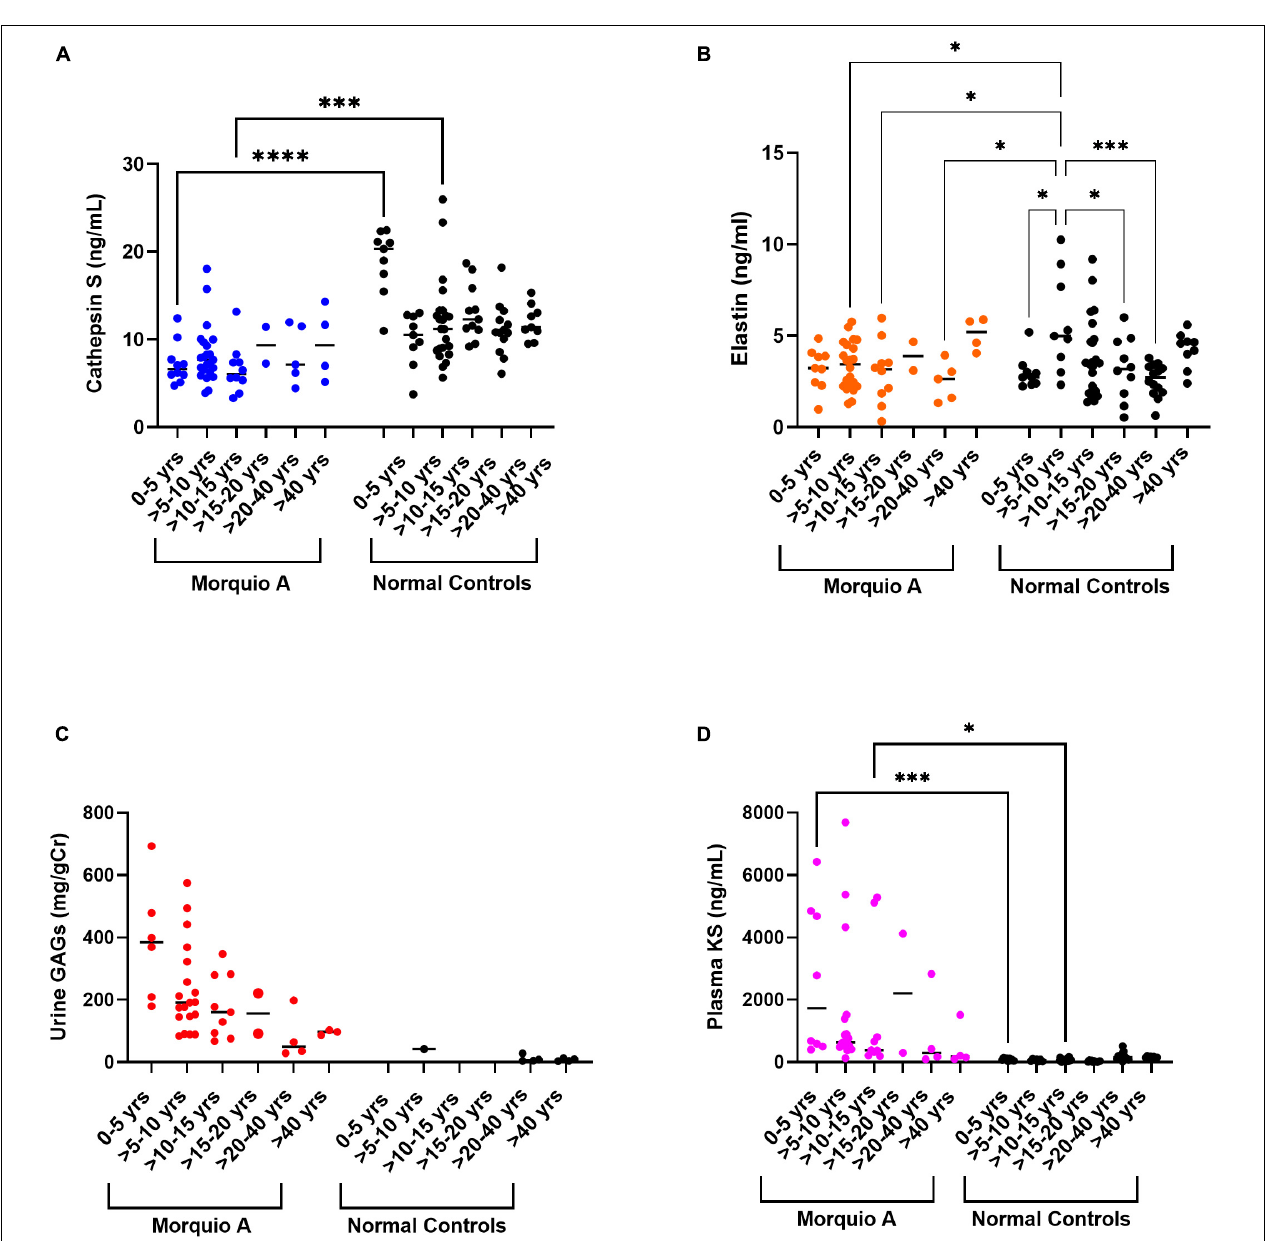
FIGURE 5 | Biomarkers comparisons between Morquio A and normal controls. Comparison of (A) Cathepsin S, (B) Elastin, (C) Urine GAGs or (D) Plasma KS, between Morquio A and normal controls stratified by age groups. Significant differences are denoted with asterisks ( ∗ p ≤ 0.05, ∗∗∗ p ≤ 0.001, and ∗∗∗∗ p ≤ 0.0001). P -values were determined by one-way ANOVA followed by ordinary one-way ANOVA multiple comparisons